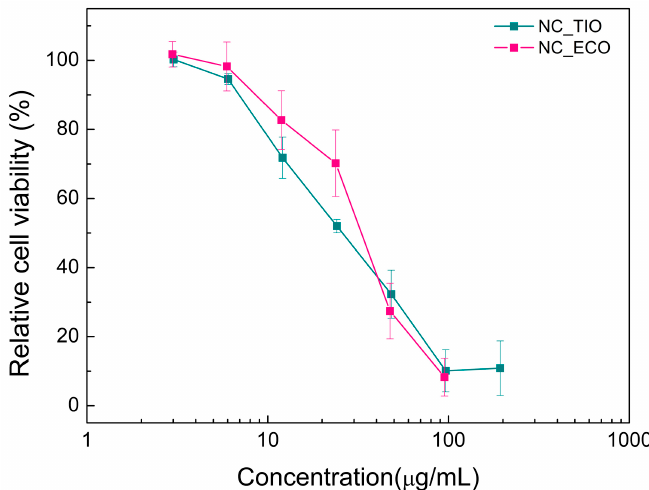
Figure 7. In vitro cytotoxicity of drug-loaded chitosan NC on human keratinocyte cell line (HaCaT) cells in 96-well plates determined using the MTT assay after 24 h. Eight replicates were performed for each treatment. Data shown are means ± SD ( n = 3).